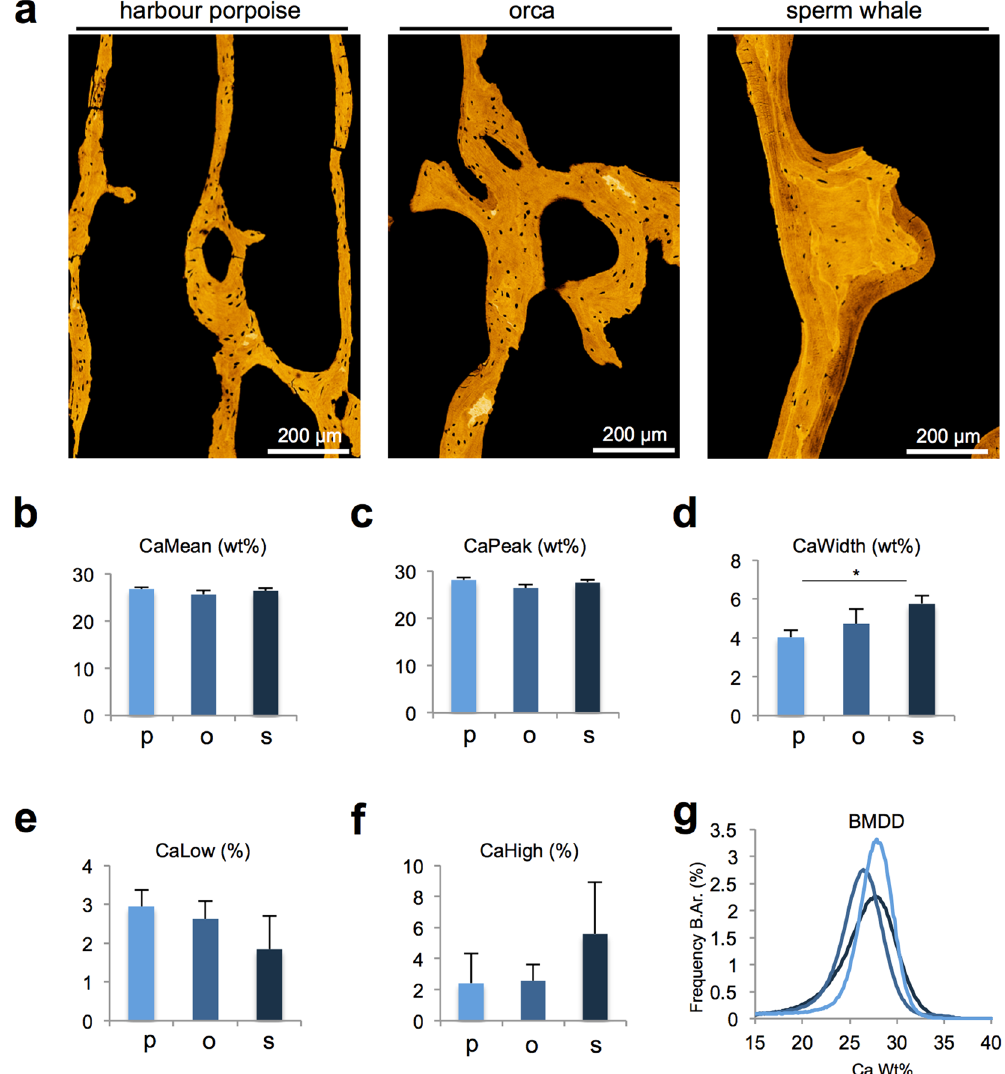
indicating a similar mineralisation pattern, whereas CaWidth was increased significantly in sperm whales, which indicates higher mineralisation heterogeneity. ( g ) Histogram of the bone mineral density distribution